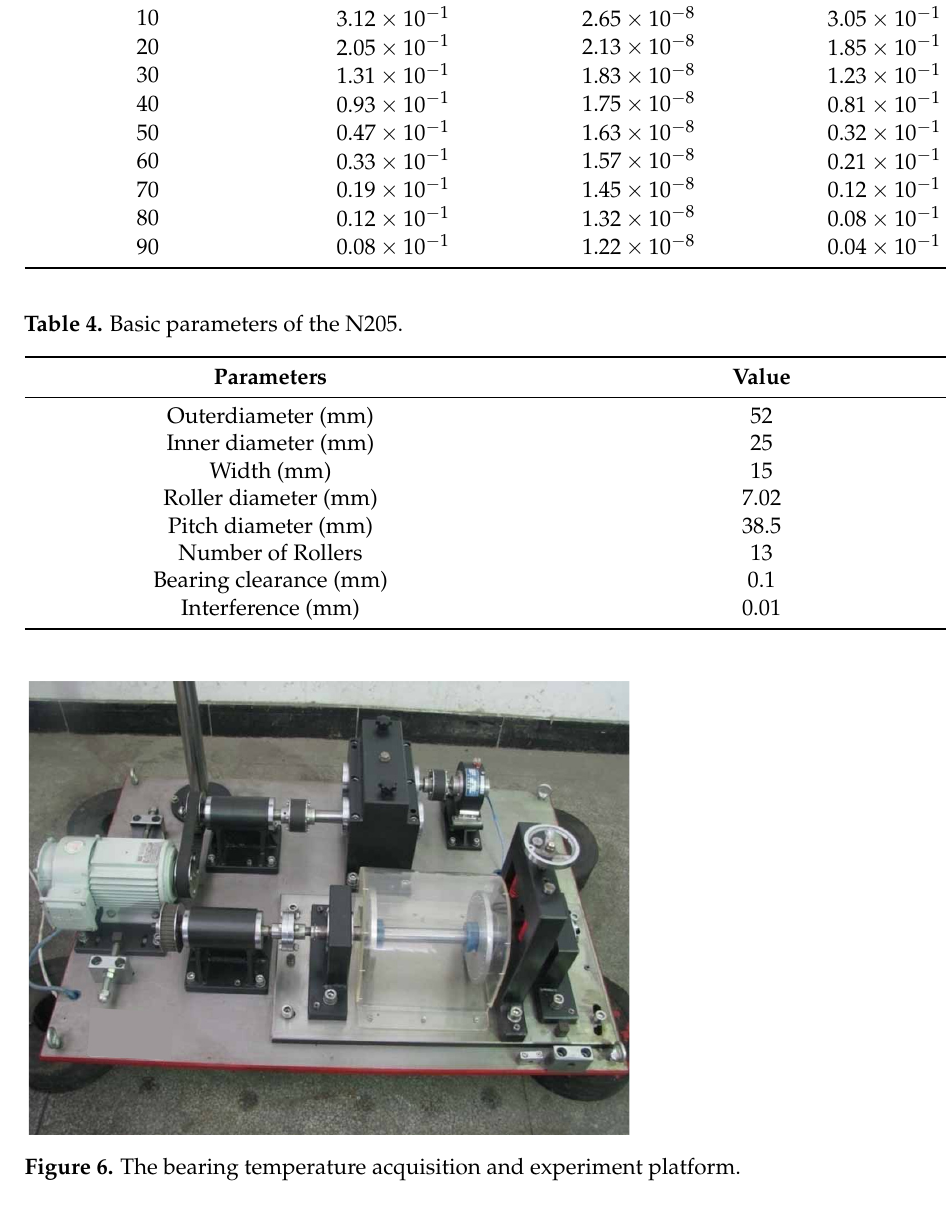
Figure 7. Schematic diagram of experimental platform structure. 5.1. The Influence of the Rotational Velocity on Temperature The temperature rises and thermal balance temperature of the good bearing and the defective bearing at the speed of 1000 r/min, 2000 r/min and 3000 r/min are compared, as shown in Figures 8 and 9, respectively. It can be found that the temperature rise process of good bearings is similar regardless of the speed of the bearings. Before the 2000 s, the temperature increased slowly and reached a stable state before 3000 s. However, the ther ‐ mal balance temperature of the bearing will increase with the increase of the rotation speed. According to the previous analysis, the influence of speed on bearing temperature is very significant, and the increase of speed also leads to the increase of heat generation between parts of the rolling bearing, which leads to the higher temperature of bearing to reach thermal balance. As can be seen from the figure, when the speed reaches 3000 r/min,